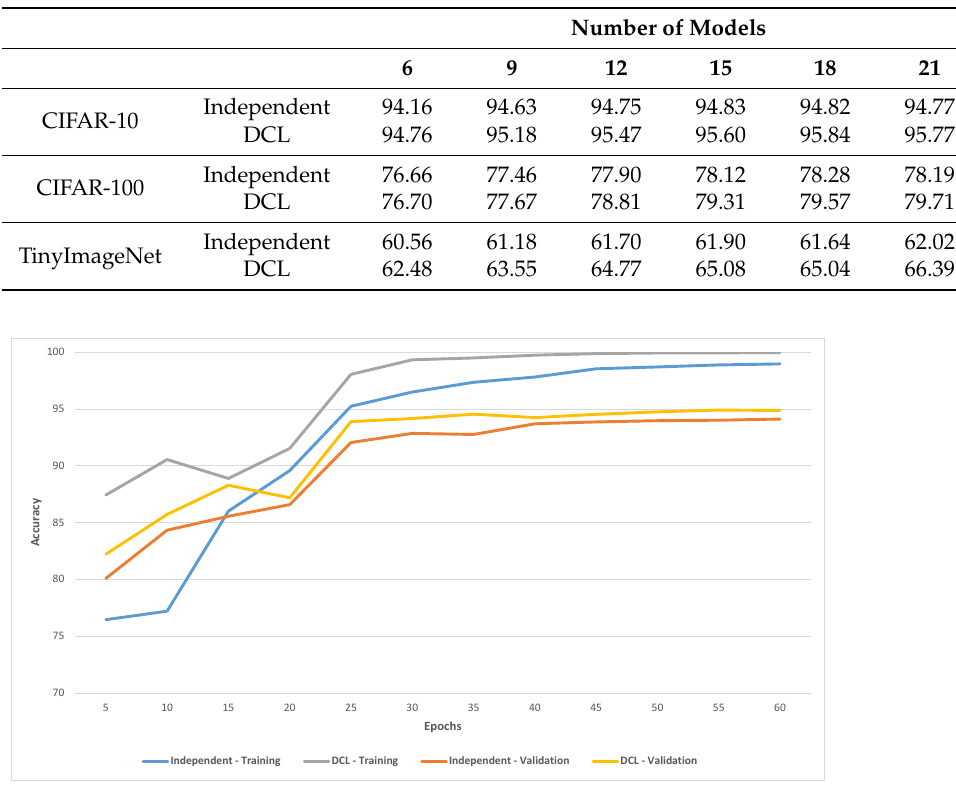
Figure 5. Training and validation accuracy of the ensemble of six independent training and DCL models on